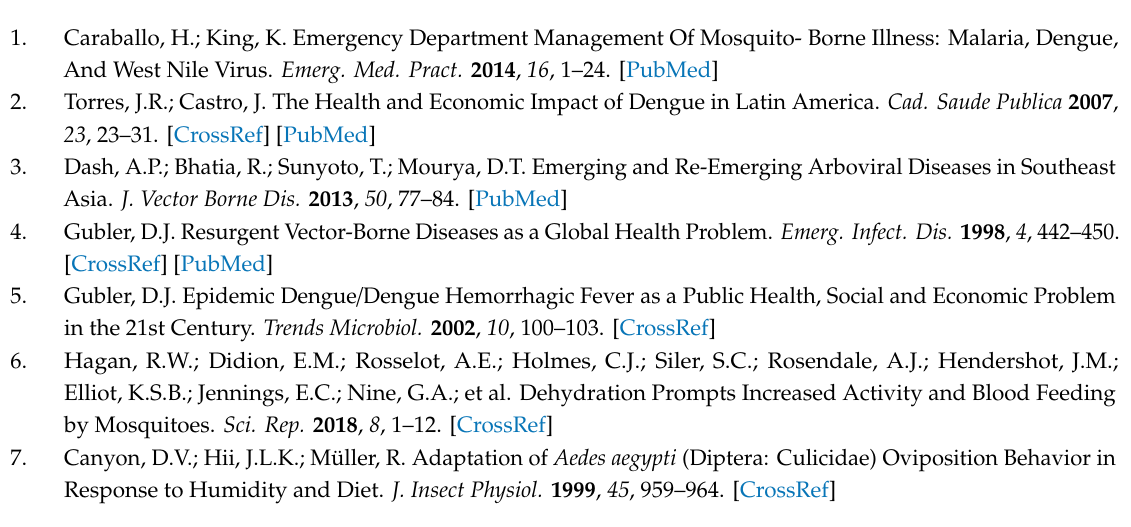
Table S1: Relationships between terms associated with three or more publications, Table S2: Term associations with two or less publications (including references [206–213]), Table S3: Factor relationships predicted within this review, Table S4: Expressions of water vapor as adapted from Slatyer [180], Table S5: Interactive table for calculation of Buck and Tetens approximations for saturation vapor pressure, vapor pressure of the air, and vapor pressure deficit from a known temperature (either above or below 0 ◦ C) and relative humidity, Table S6: Interactive table for calculation of water vapor approximations from relative humidity and temperatures (above 0 ◦ C) for multiple data entries, Table S7: Interactive table for calculation of water vapor approximations from relative humidity and temperatures (below 0 ◦ C) for multiple data